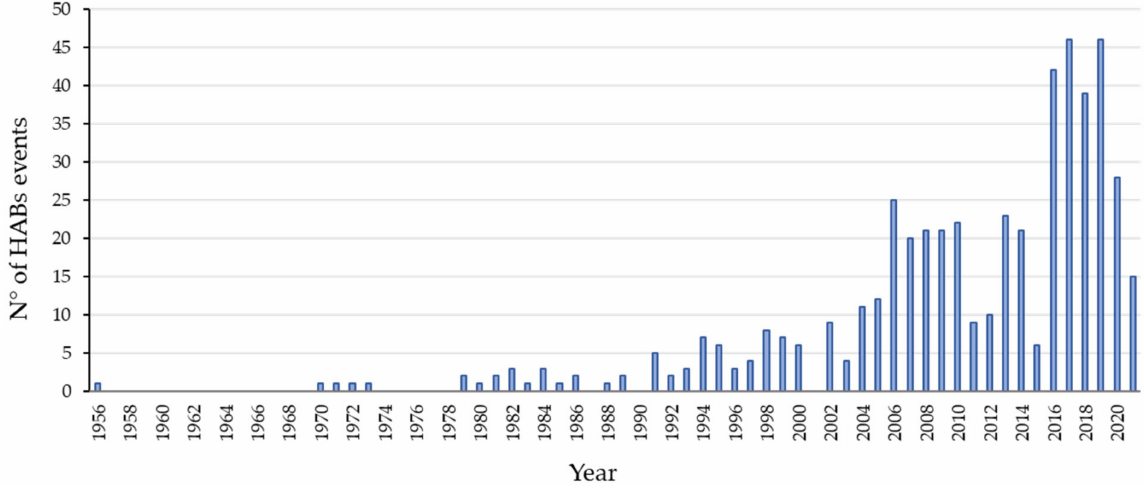
Figure 4. Distribution of HABs events per year in Chile from 1956 to 2021.